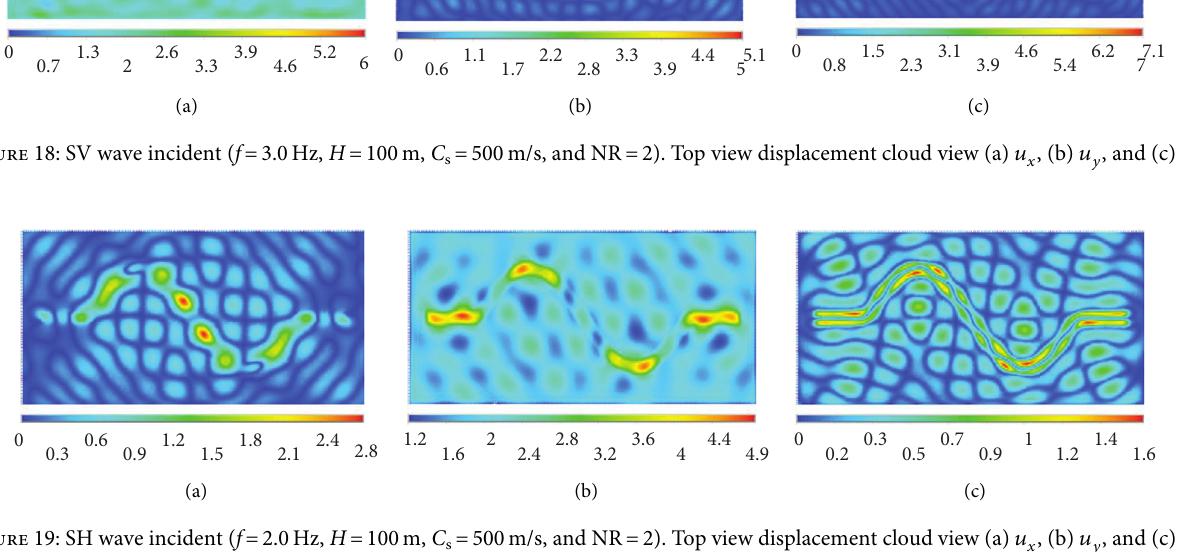
u u x , (b) y , and (c) z .